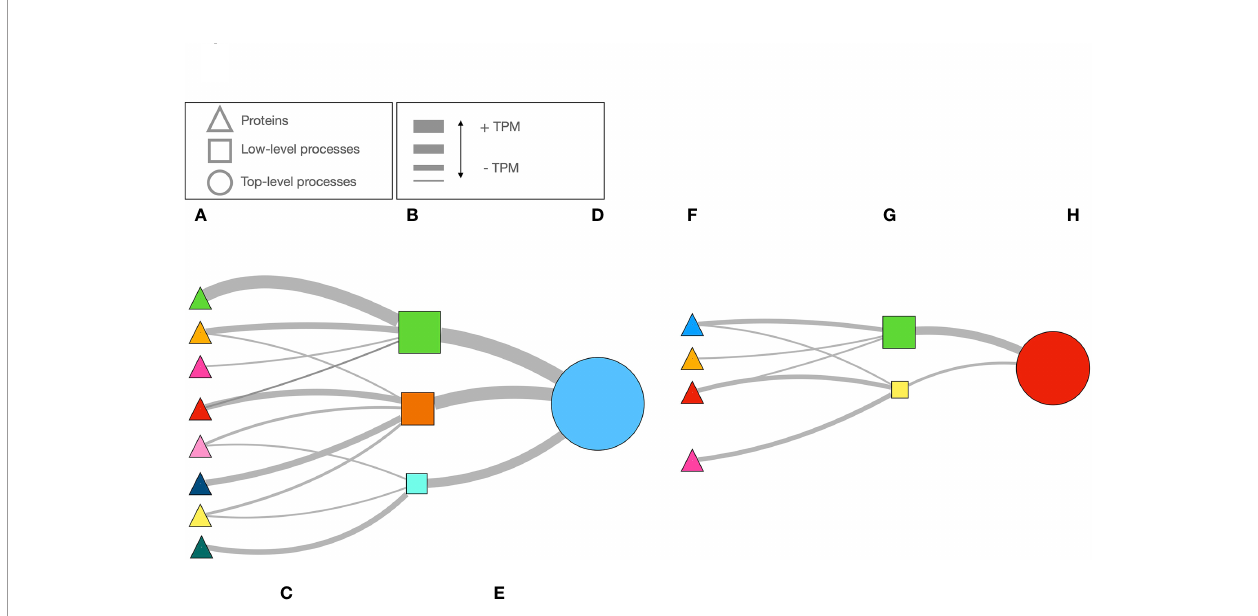
FIGURE 1 | A schematic example of how the network is build using data of the expression of proteins, and how the importance of each biological process is calculated. Once the proteins are selected using very astringent criteria (A) , public databases are queried to obtain the biological processes in which they take part (B) . This is what we call “ low-level ” biological processes (e.g., the “ children processes ” ). The strength of the link between the protein and the process is the TPM of the protein, that we schematically show as the width of the line (C) . With the TPM, we calculated the PageRank index for each process in (B) . We schematically shown the PageRank as different sizes of the squares in (B) . Each low-level process (i.e., “ fermentation of sucrose ” ) is part of a cascade of biological processes, of which we identi fi ed the top ones in the hierarchical chain (i.e., “ metabolism ” , the “ parent ” process ” ). From the sum of TPM ’ s of the proteins impacting each low-level process, as before, the width of the lines (E) represent the strength of link. The PageRank value of the top-level process (D) is calculated. However, if the number of proteins or their TPM are low (F) the PageRank of the chain of processes will be lower (G, H) . The opposite result (not illustrated) would happen in the contrary case (more proteins expressed or with higher TPM). PageRank is a very valuable index to measure the “ popularity ” or the “ coolness ” of a process, and therefore an explicit statistical description of its importance in the complete metabolical chain